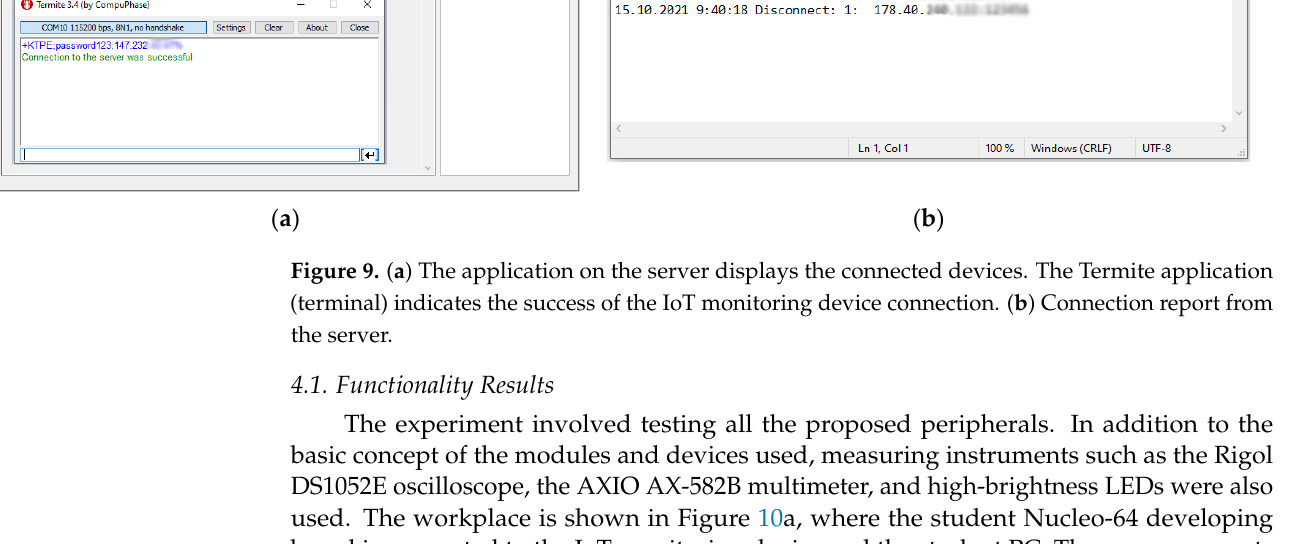
Figure 9. ( a ) The application on the server displays the connected devices. The Termite application (terminal) indicates the success of the IoT monitoring device connection. ( b ) Connection report from the server.